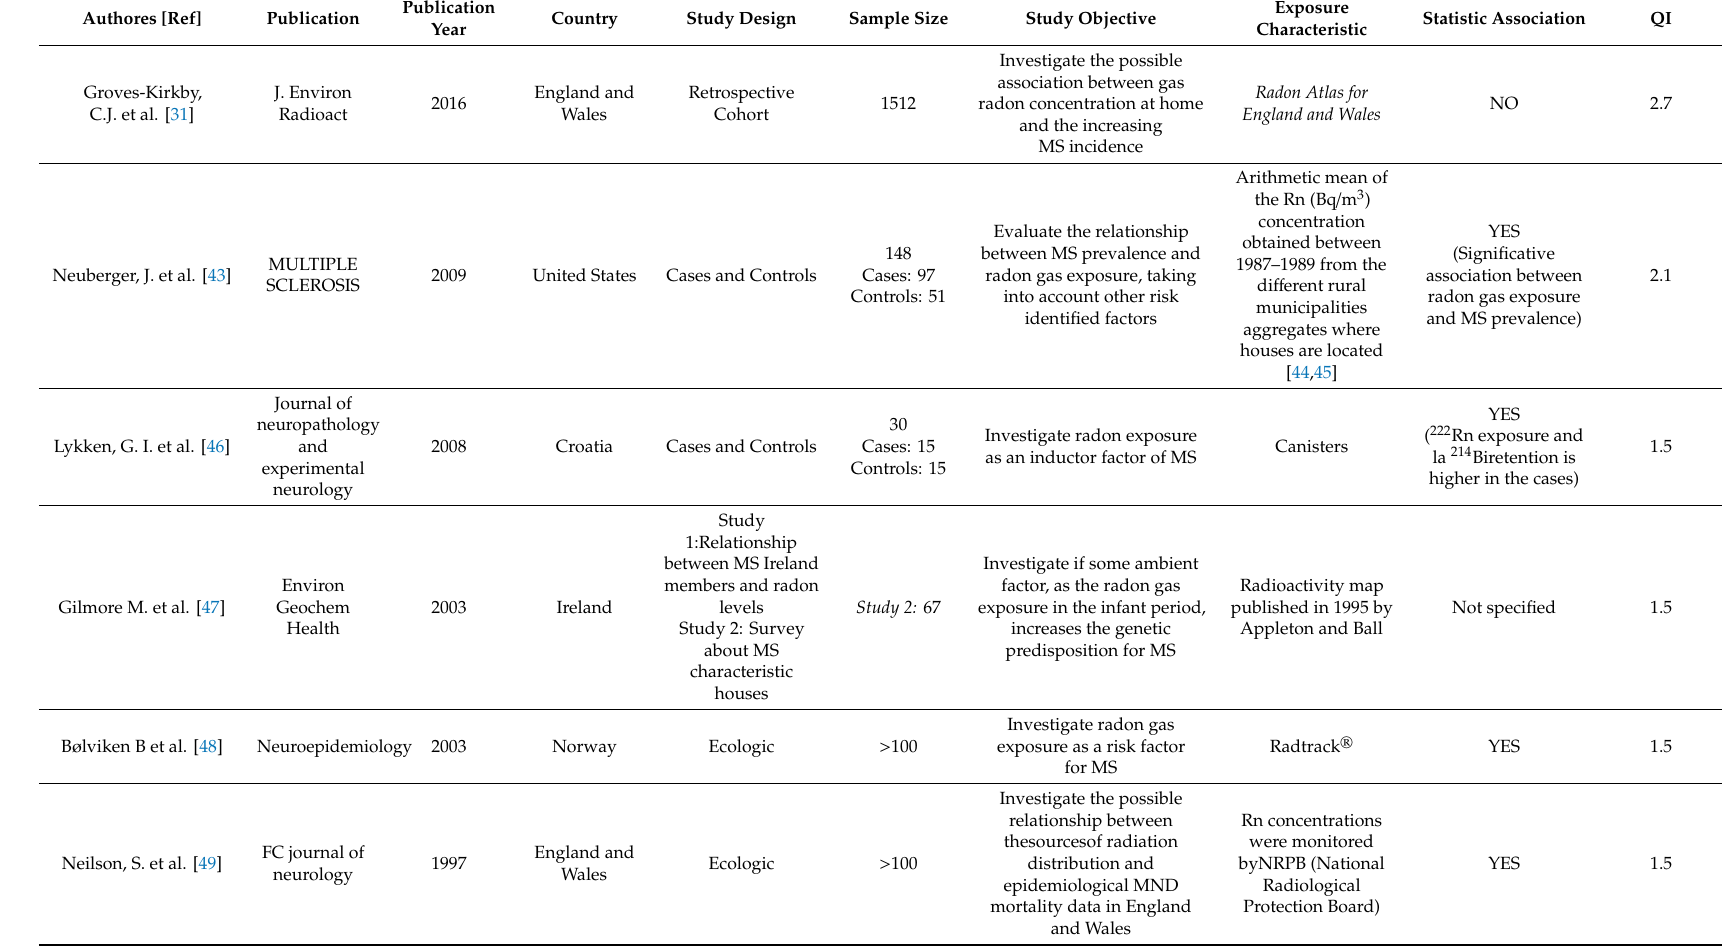
Table 2. Description of studies included in the